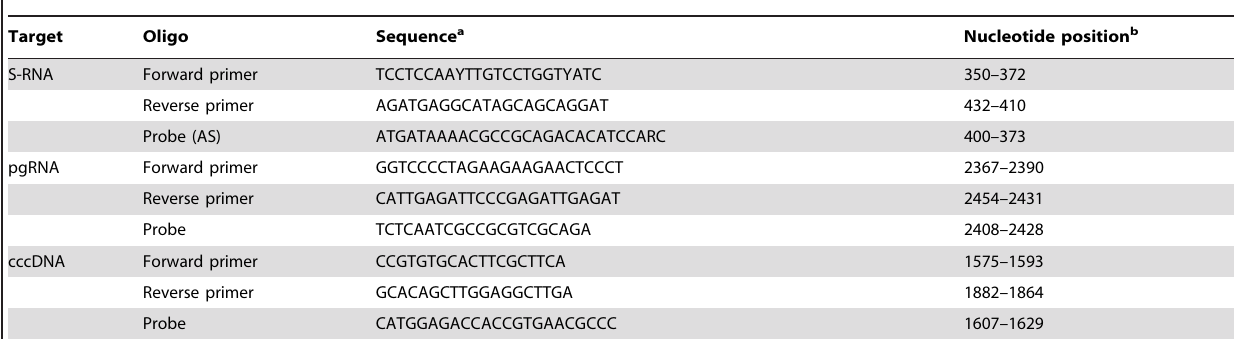
Table 2. Oligonucleotide sequences of primers and probes.